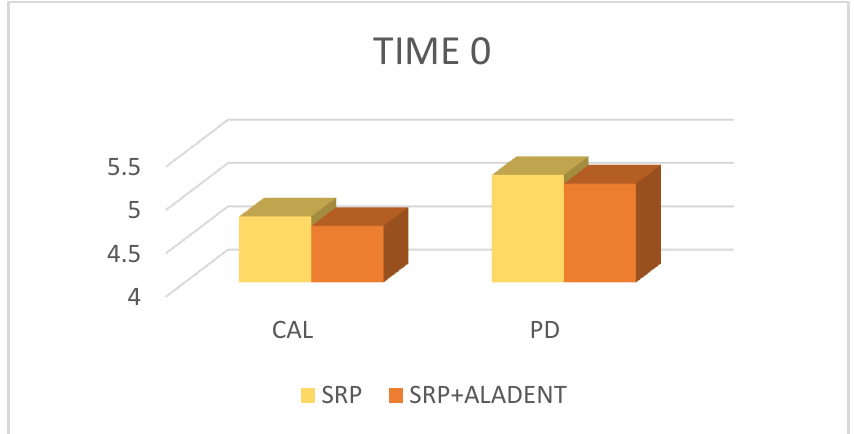
Figure 4. CAL and PD mean values (mm) of the selected sites before treatment with SRP alone and SRP plus ALADENT.